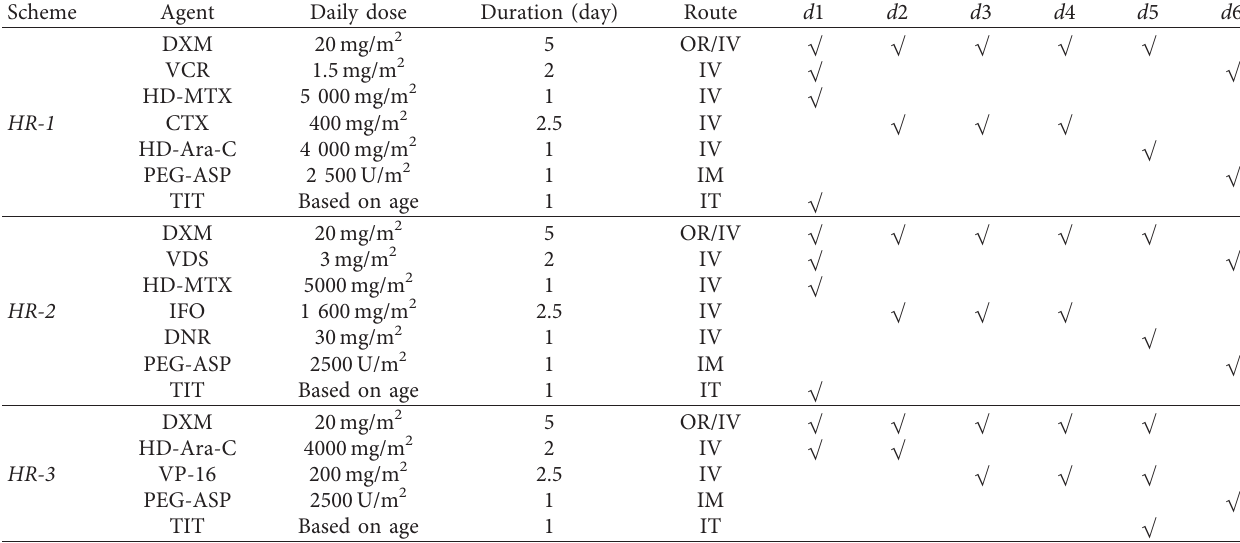
Table 1: Primary chemotherapeutic agents in HR consolidation therapy.